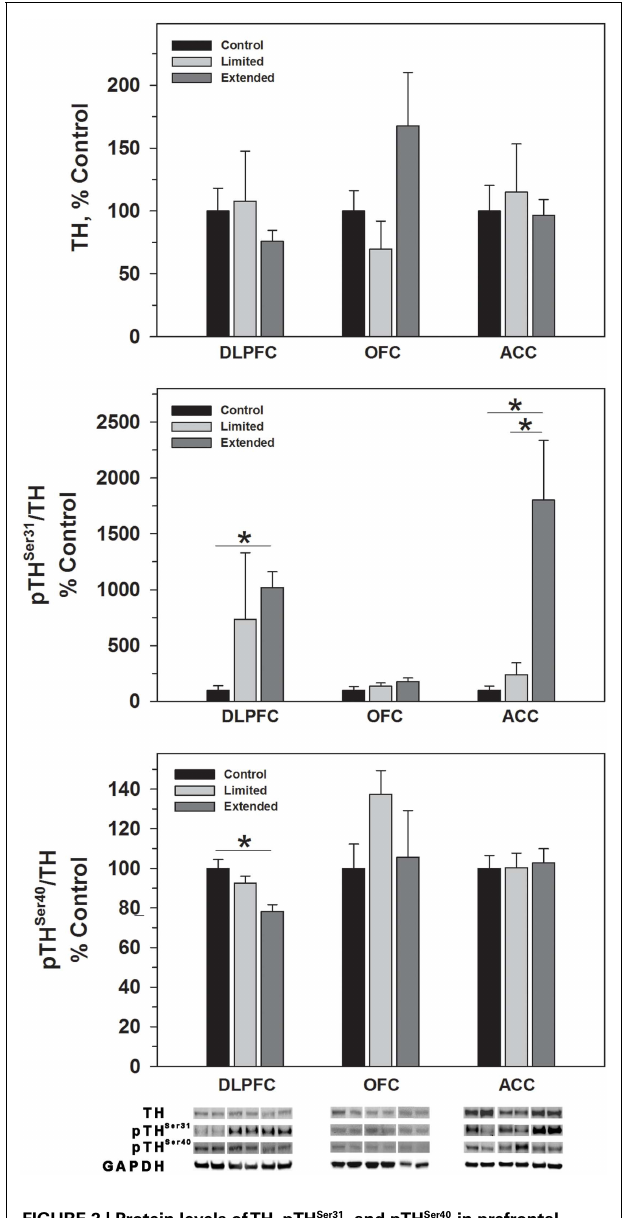
FIGURE 2 | Protein levels ofTH, pTH Ser31 , and pTH Ser40 in prefrontal cortical regions as a function of cocaine self-administration exposure determined byWestern blot analysis . Cytosolic fractions were isolated as described in the Section “Materials and Methods” and 10 µ g were separated on 10% SDS-PAGE. Data are expressed as mean ( ± SEM) of the percent of control values per amount of protein loaded. Asterisks indicate a significant difference ( P < 0.05). Bottom Panel: Representative bands from two subjects per group per